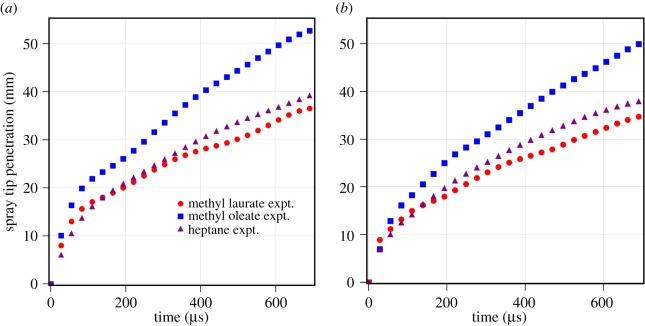
Measured spray tip penetration of methyl laurate, methyl oleate and n-heptane. (a) Pinj=1500 bar and Pamb=30 bar. (b) Pinj= 1500 bar and Pamb=40 bar.